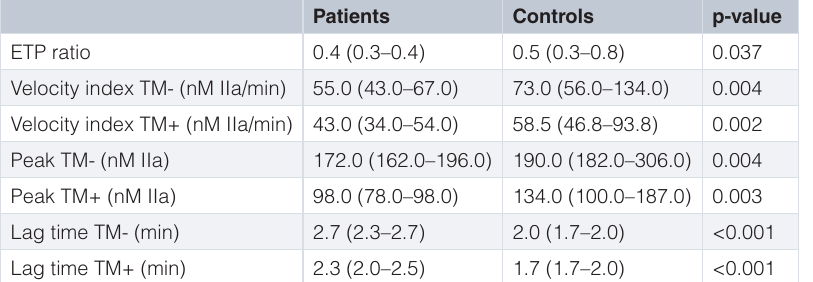
Table 2. Parameters derived from thrombin generation curves generated in absence and presence of TM. Data are presented as medians with interquartile range.